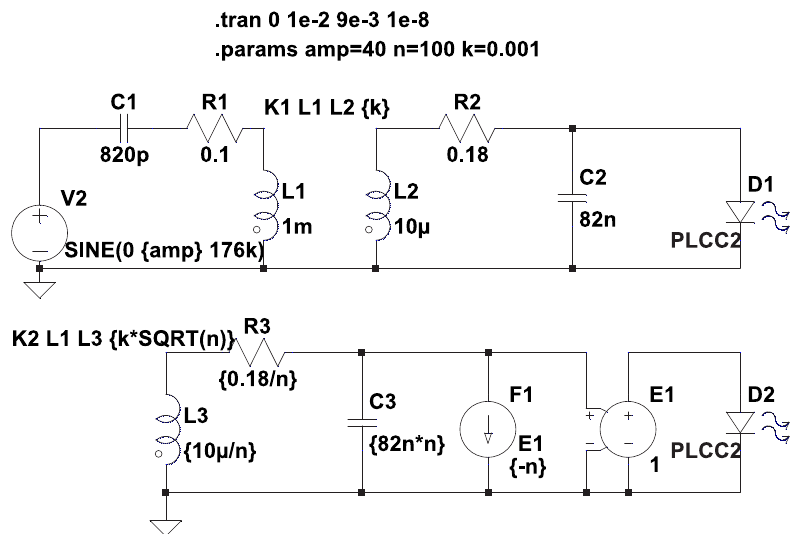
Figure 4. The upper righthand circuit represents a single WLE-receiver. The lower circuit stands for a lumped network of n